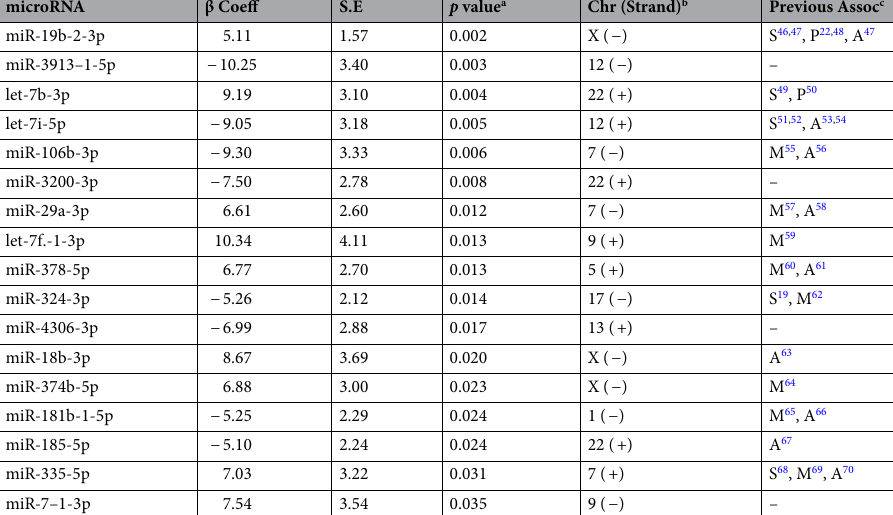
Table 2. microRNA in whole blood circulating in the early aftermath of motor vehicle collision (MVC) that predict persistent neck pain related disability trajectories following MVC trauma. a p values were calculated using repeated measures mixed models. b’ Chr’ refers to the chromosome name/number from where each microRNA is transcribed and ‘strand’ refers to whether it comes from the sense ( +) or antisense ( −) strand of the genome c Previous assoc = References describing a previously identified role for the microRNA in stress system biology (S), pain pathobiology (P), skeletal muscle (M), or adipose tissue (A). Coeff. = β coefficient from linear mixed models. S.E. = standard